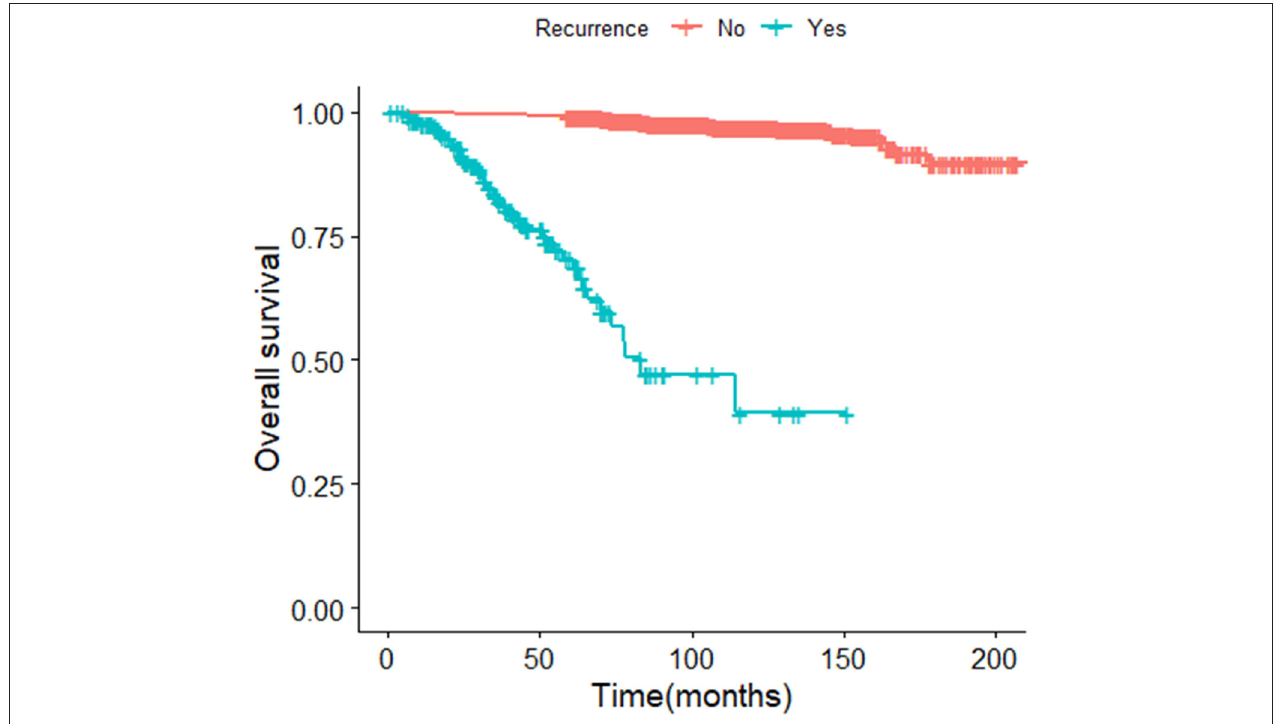
FIGURE 3 | Kaplan-Meier curve of overall survival for early EC patients ( p < 0.001).